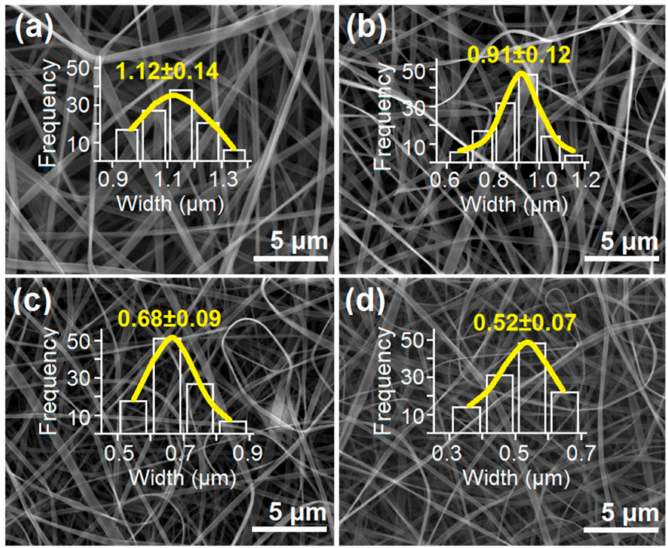
Figure 5. SEM images of resultant zein nanoribbons, with their width distributions. ( a ) Z1; ( b ) Z2; ( c ) Z3; ( d )